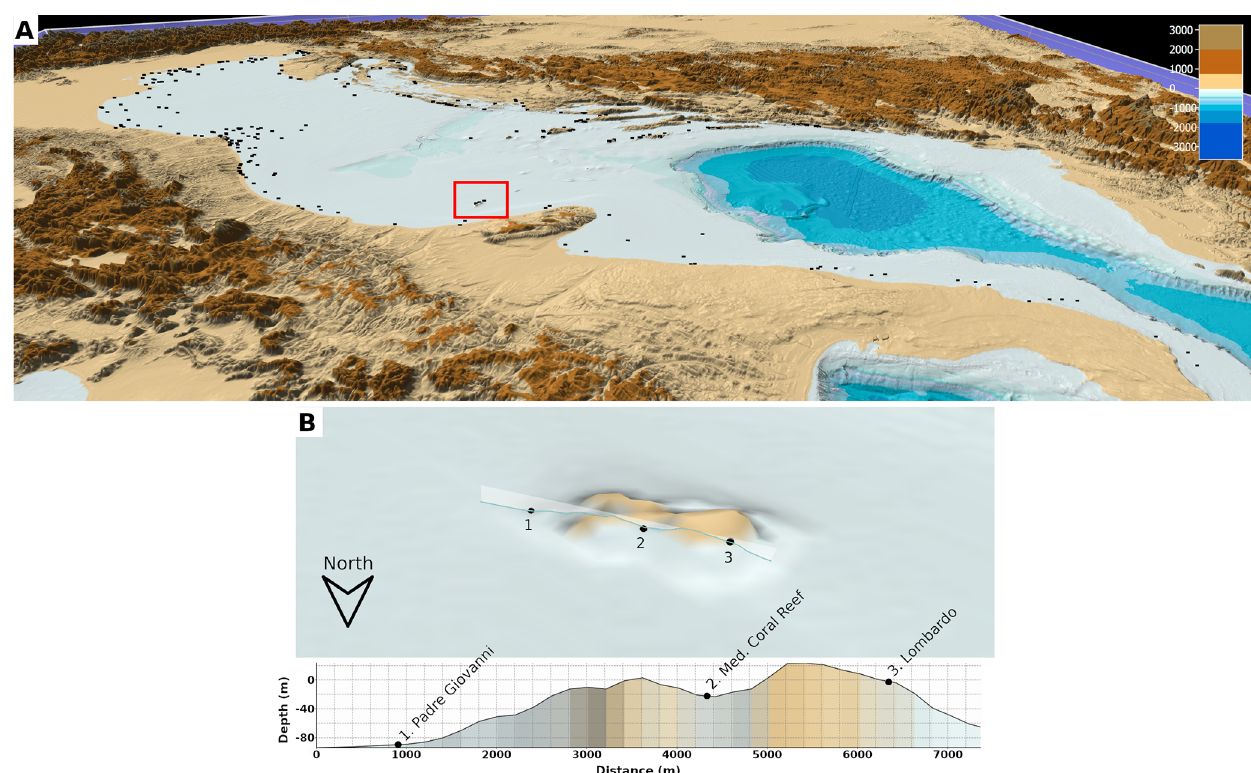
Figure 6. A 3D visualization of the spatial distribution of natural reefs, artificial reefs, and wrecks in the Adriatic Sea (a) . In the red square, the area concerning the zoom reported below. A view of Tremiti Islands and the vertical terrain section from left to right crossing three elements (b) : Padre Giovanni and Lombardo wrecks (points no. 1 and 3) and Mediterranean mesophotic coral reef (point no.